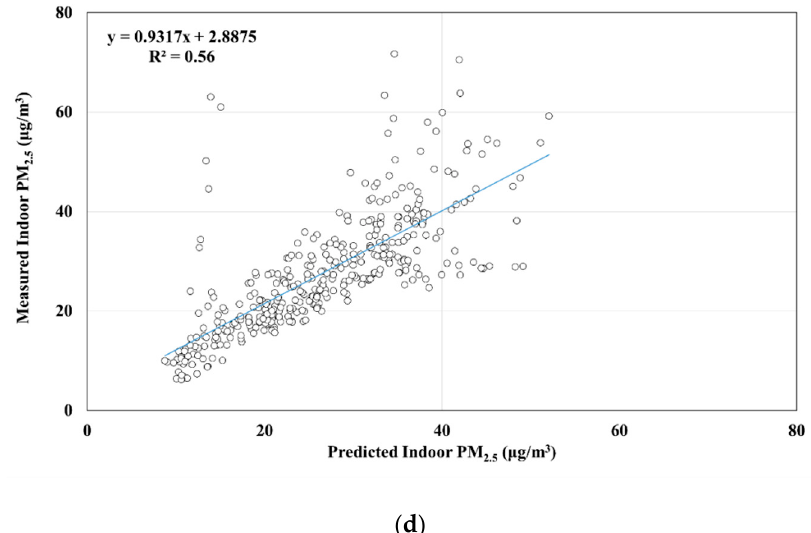
Figure 3. Relationship between predicted and measured hourly average indoor PM 2.5 concentration across seasons: ( a ) spring, ( b ) summer, ( c ) fall, and ( d ) winter.